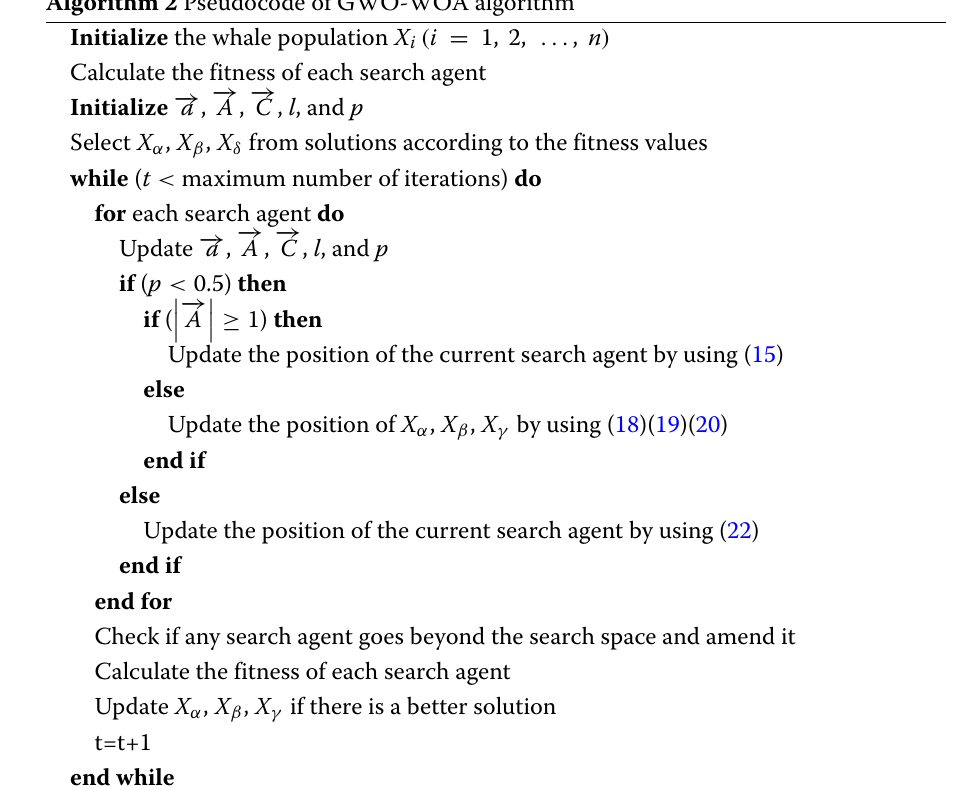
Algorithm 2 Pseudocode of GWO-WOA